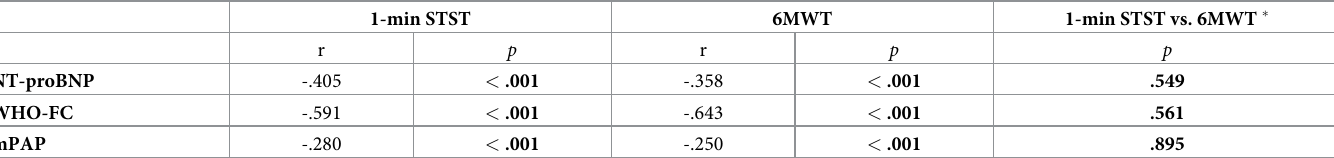
Table 2. Correlations between exercise tests and PH severity markers.